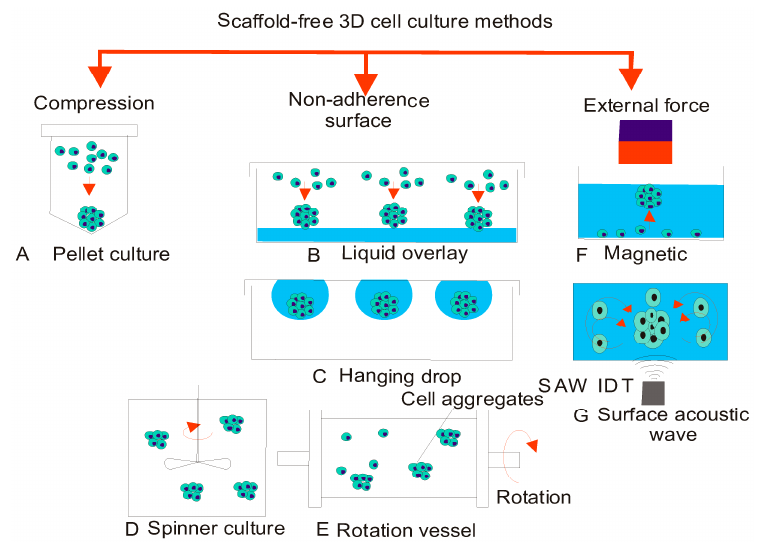
Figure 6. Conventional methods for spheroid generation: ( A ) pellet culture; ( B ) liquid overlay; ( C ) hanging drop; ( D ) spinner culture; ( E ) rotating vessel; ( F ) magnetic force; and ( G ) surface acoustic